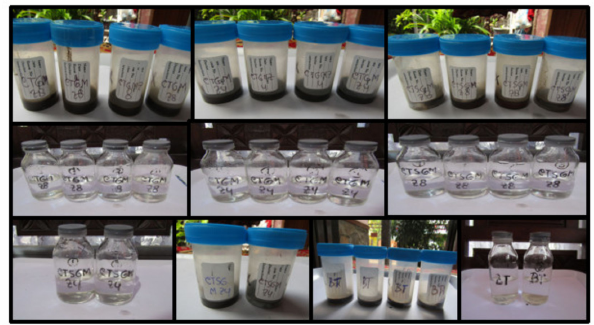
Figure 21. Residues and filtrates after test of pesticide degradation.